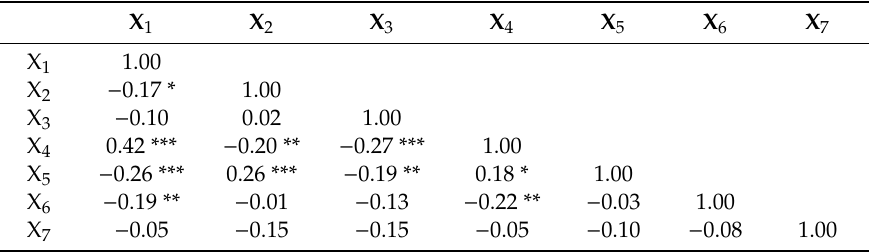
Table 1. Correlation matrix of the seven variables 1